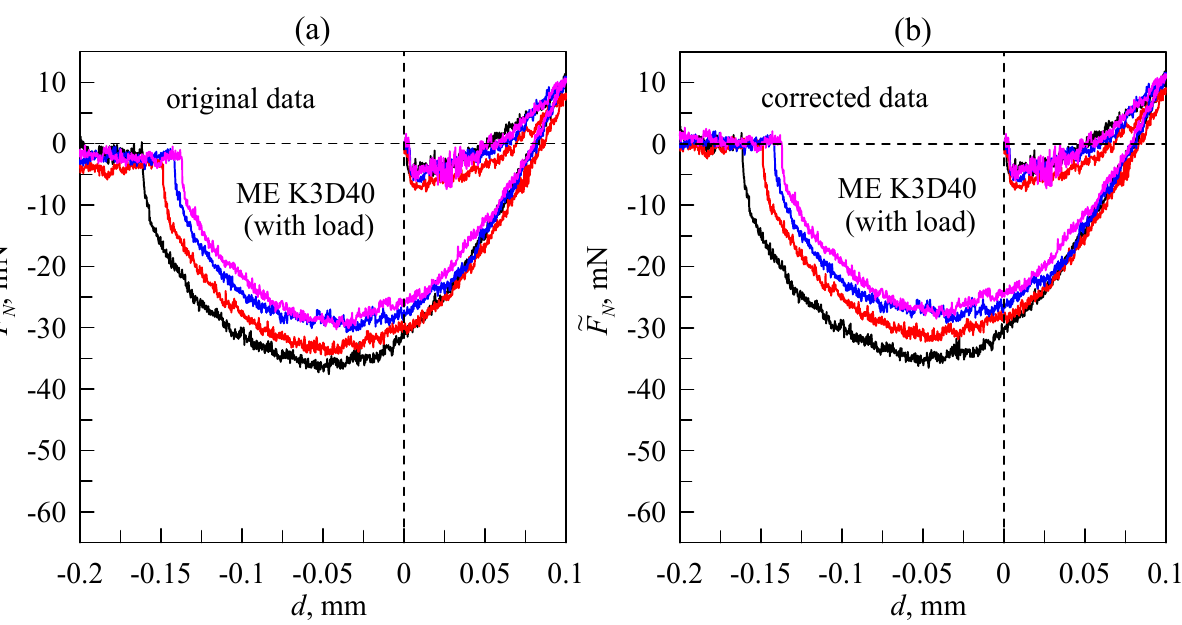
Figure 7. Dependencies of the normal force ( F N ) on the indentation depth ( d ), similar to curves shown in Figure 6 but measured by the K3D40 force sensor. Original ( a ) and corrected ( b ) data. Curves, corresponding to the same experiments, are denoted by the same color in both panels.